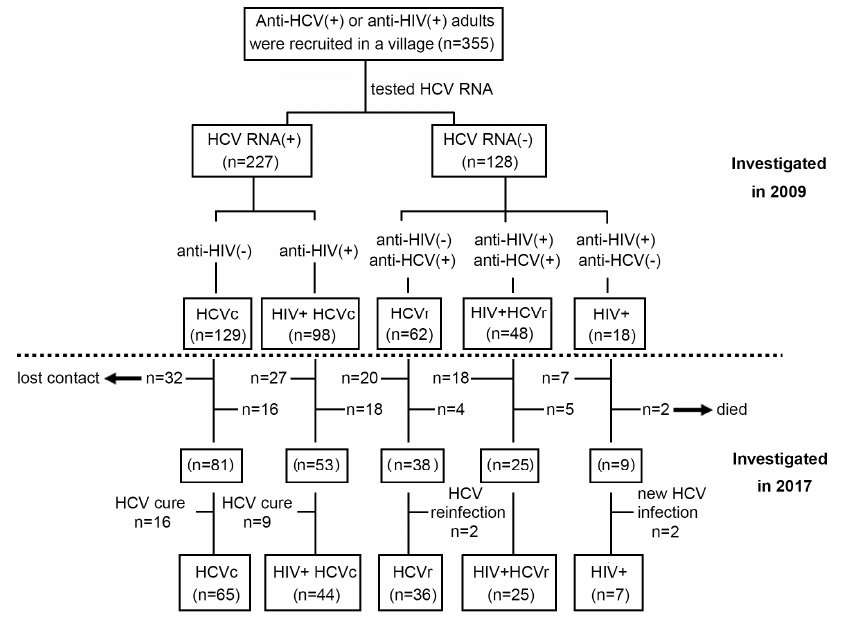
Figure 1. A flow diagram representing the recruitment of 355 anti-HCV (+) or anti-HIV (+) patients for the study. Above and below the dashed line are the initial follow-up visit in 2009 and the second visit in 2017, respectively. Patients with HIV − HCVc ( n = 65), HIV+ HCVc ( n = 44), HCVr ( n = 36), HIV+ HCVr ( n = 25), and HIV + mono-infection ( n = 7) were enrolled for analysis after inclusion and exclusion. HCV, hepatitis C virus; HCVc, chronic HCV carriers; HCVr, HCV resolvers; HIV, human immunodeficiency virus. Table 1. The demographic and clinical characteristics of all individuals enrolled in the study in